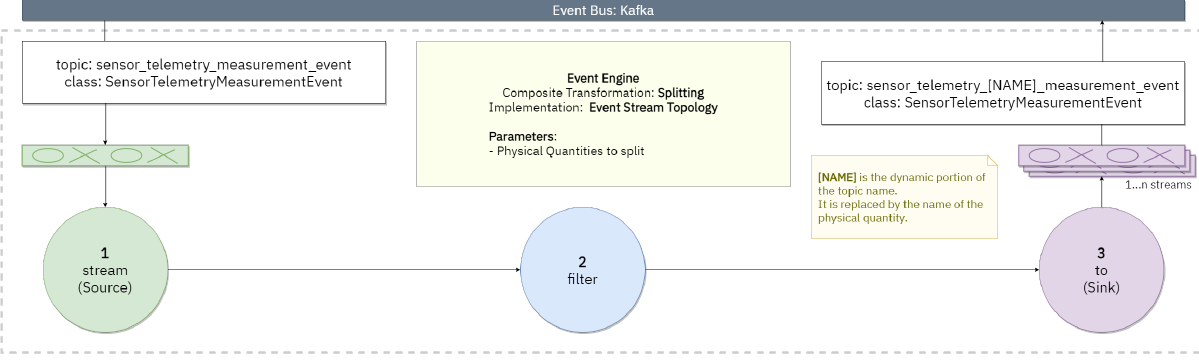
Figure 4. Event processor topology of Splitting Composite